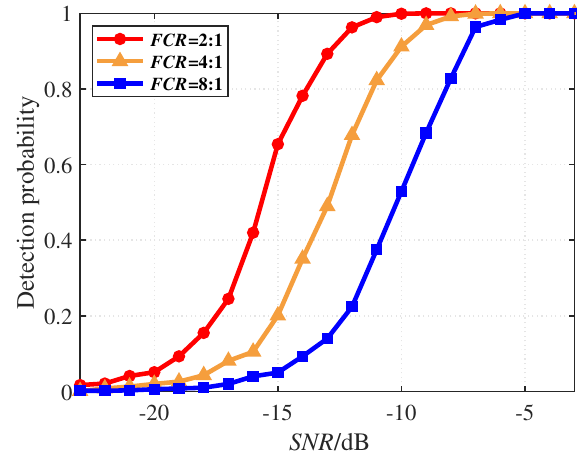
Figure 6. The detection probabilities with different SNR